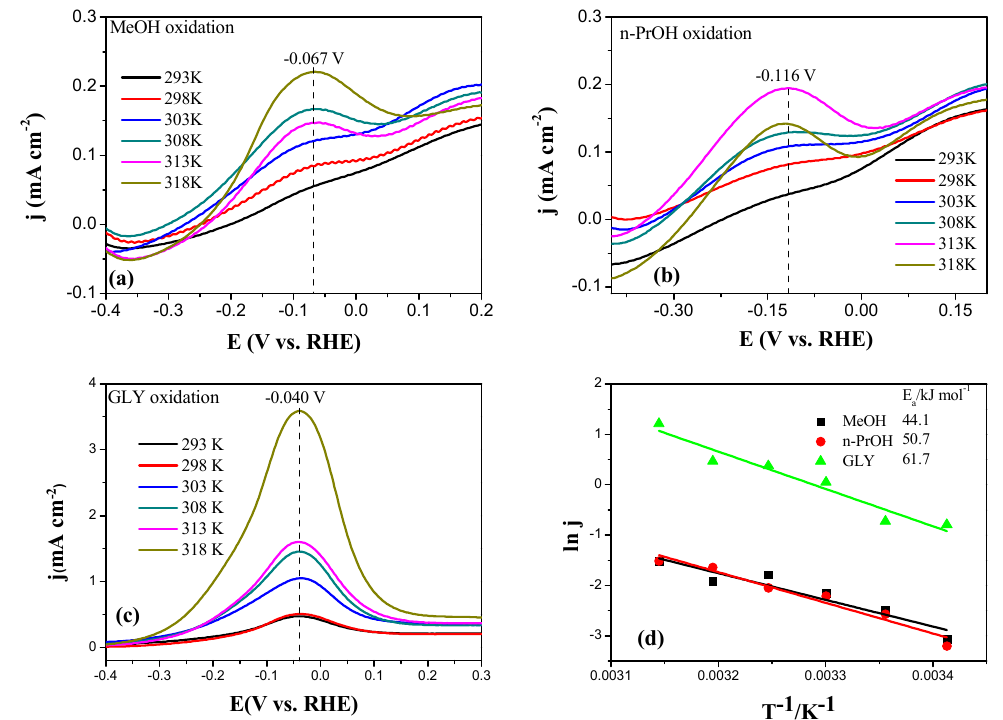
Figure 14. ( a – c ) LSVs of Pt electrode in 0.1 M KOH + 0.025 M alcohol; ( d ) Arrhenius plot of alcohol eletro-oxidation on Pt at peak potentials.